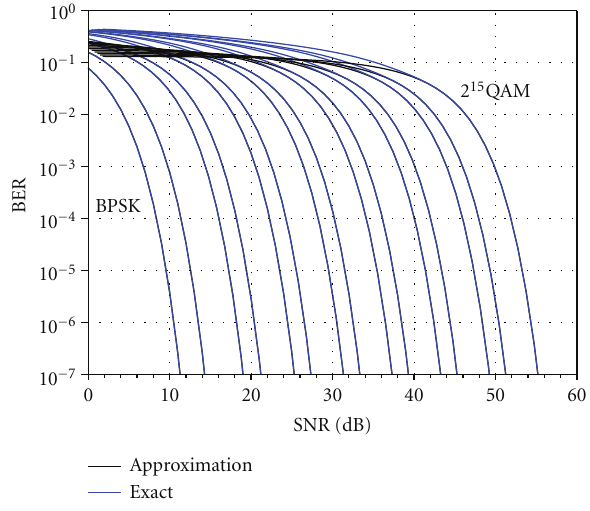
Figure 1: Exact BER curves and approximations